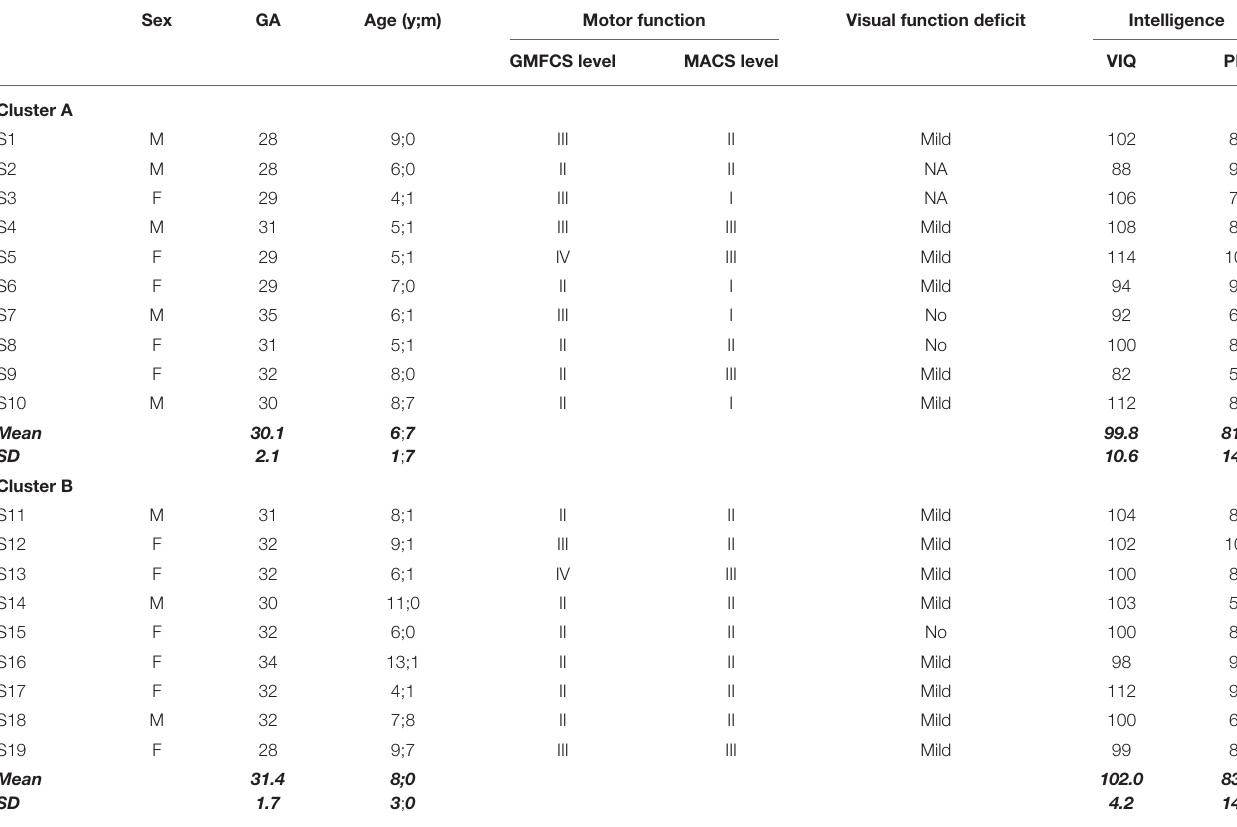
TABLE 1 | Clinical characteristics of the study group of children with pSD.